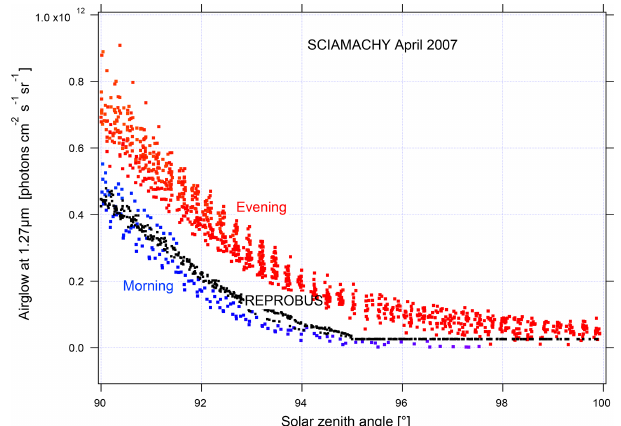
Figure 17. Intensity of the inverted airglow as a function of the re- flected solar spectral radiance (in units of Wm − 2 sr − 1 µm − 1 ). The points are coloured according to the SZA from blue to red from 27 to 60 ◦ .